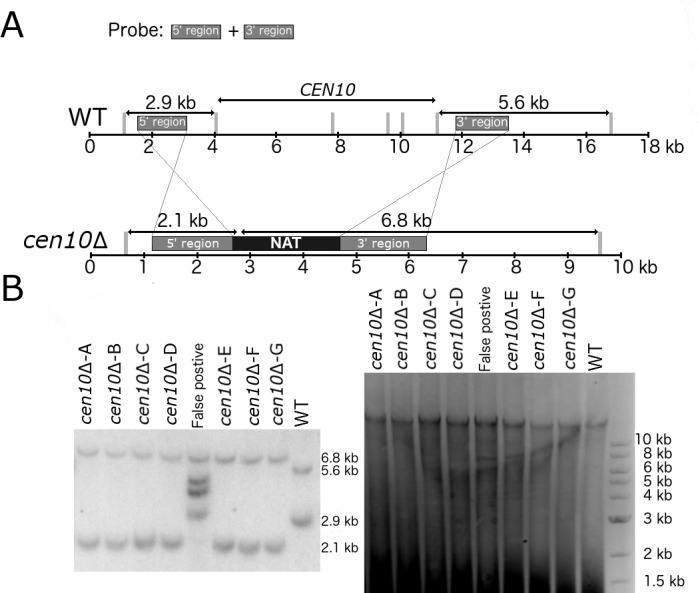
Centromere 10 is deleted in cen10∆ isolates.(A) The region corresponding to the native centromere 10 of the wild type and cen10∆ mutants is shown. Upstream and downstream flanking regions, used for homologous recombination, are indicated with rectangles (labeled ‘5’ region’ or ‘3’ region’). The nourseothricin drug resistance gene cassette is indicated with a rectangle, (labeled NAT). Grey lines indicate XbaI restriction sites. PCR products of the 5’ and 3’ regions were used as Southern blot probes, and the expected restriction pattern is indicated above. (B) Southern blot analysis for the wild-type and cen10∆ mutant strains is presented. Left panel shows the Southern blot, right panel shows the ethidium bromide-stained gel prior to Southern blotting. Both the wild type and cen10∆ mutants have the expected restriction pattern which is shown in panel A.